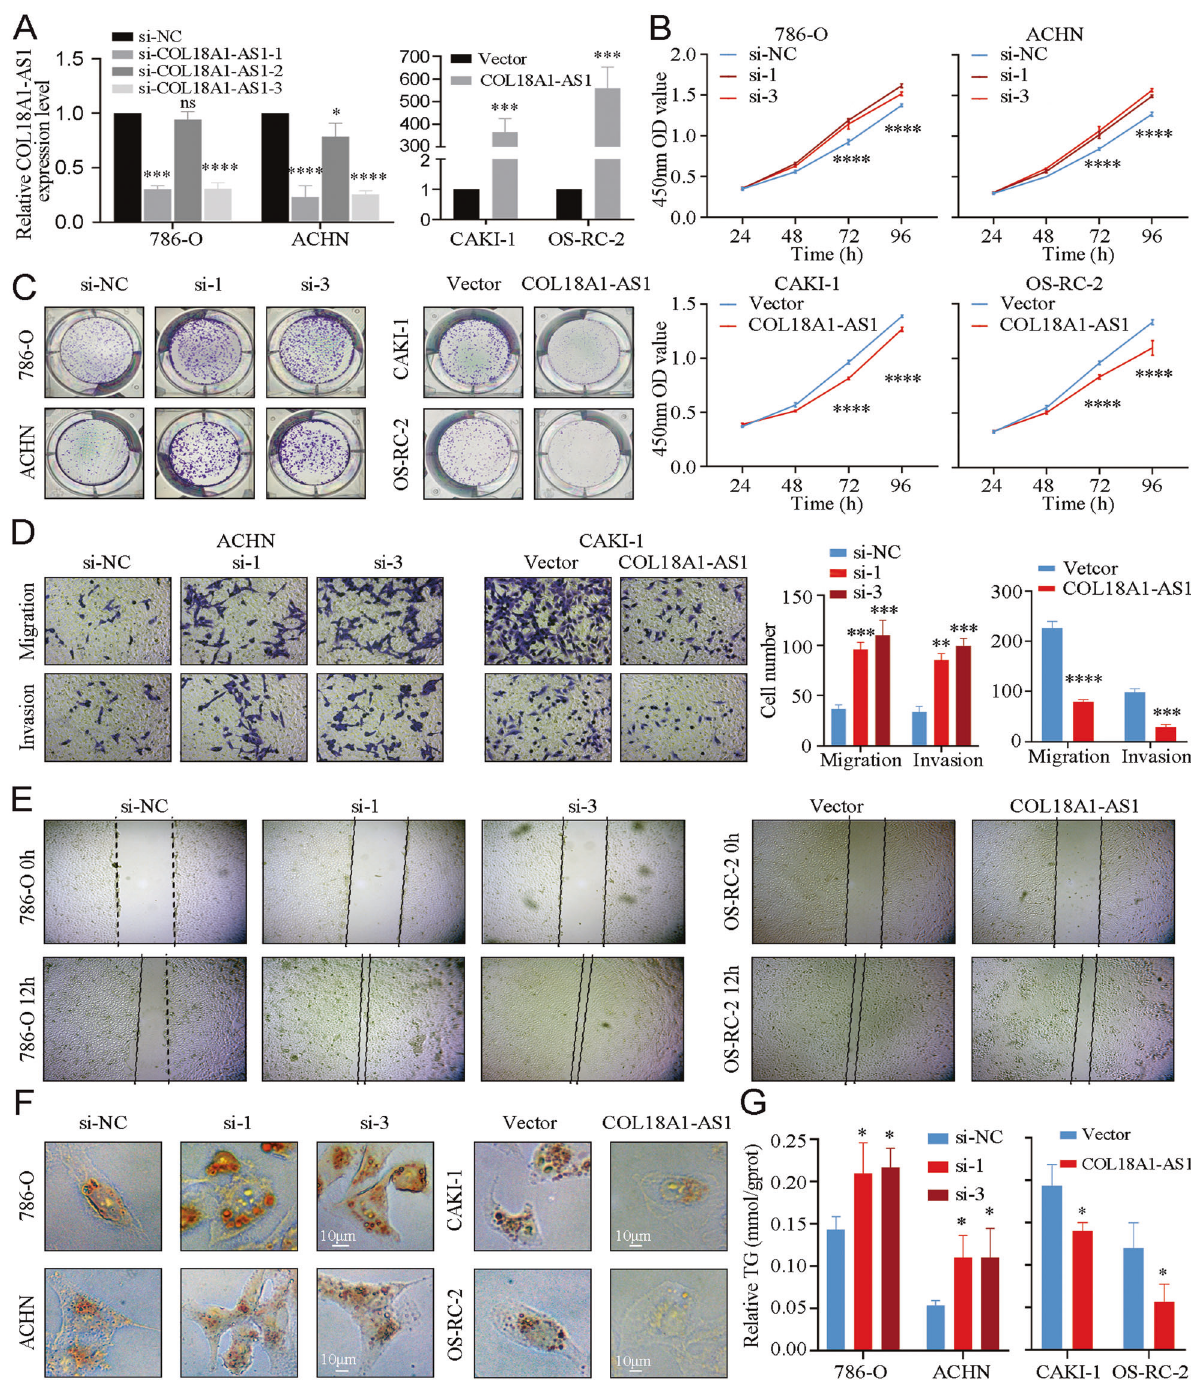
Fig. 2 COL18A1-AS1 repressed ccRCC progression and eliminated lipids accumulation in vitro. A qRT-PCR assays were applied to analyze the expression level of COL18A1-AS1 after transfection by si-RNA or COL18A1-AS1 overexpression vector for 24 h in RCC cells. B , C Cell proliferation ability of RCC cells after knocking down or overexpressing COL18A1-AS1 was determined using CCK8 assays or colony formation assays. D , E Cell migration and invasion ability of RCC cells was measured with Transwell assays or wound healing assays (Magni fi cation: ×100 for Transwell assays and x40 for wound healing assays). F Photomicrographs of Oil Red staining of RCC cells knocked down or overexpressed COL18A1-AS1 compared with the negative control. Scale bars, 10 μ m. G Relative TG (mmol/gprot) levels in RCC cells with COL18A1-AS1 overexpression or knockdown assessed by a triglyceride assay kit. * P < 0.05, ** P < 0.01, *** P < 0.001, **** P < 0.0001. Error bars indicate mean ± SD. All the experiments were performed in COL18A1-AS1 repressed tumor proliferation and metastasis methylation at the CpG islands within its promoter. COL18A1- through promoting lipid browning and consumption in vitro AS1 could competitively bind miR-1286 to increase the and in vivo. expression of KLF12. Restoring the epigenetically silenced